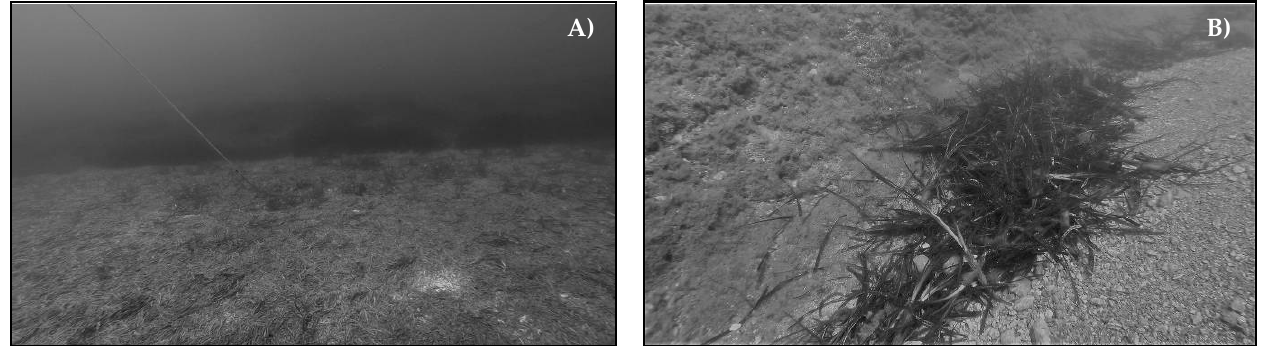
Figure 4. Example of natural storage site where cuttings were harvested at Capo Carbonara ( A ) and Elba Island ( B ).